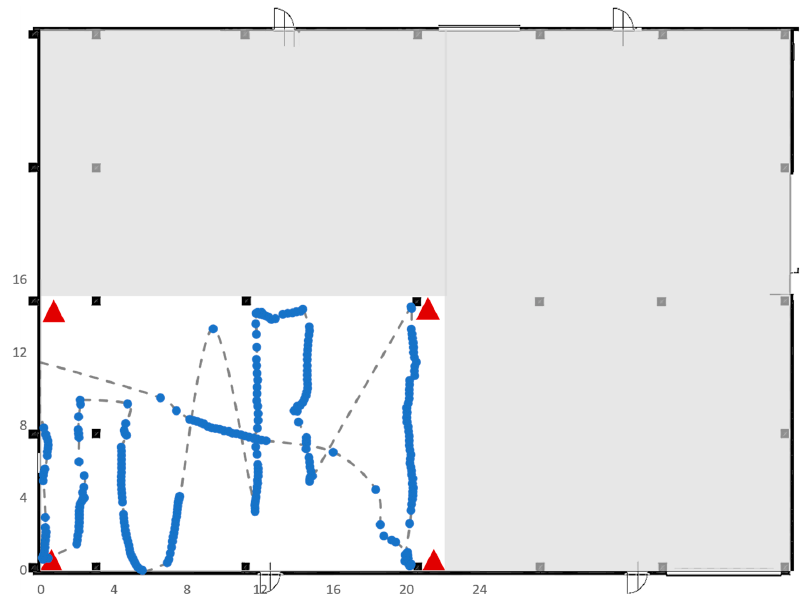
Figure 20 . Trajectory followed by the tag in Test 3. Figure 20. Trajectory followed by the tag in Test 3.